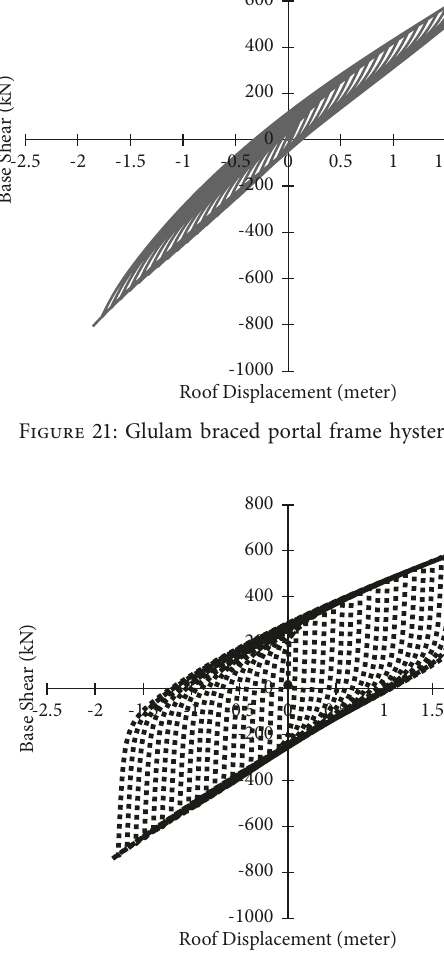
Figure 22: TS-BRB portal frame hysteresis